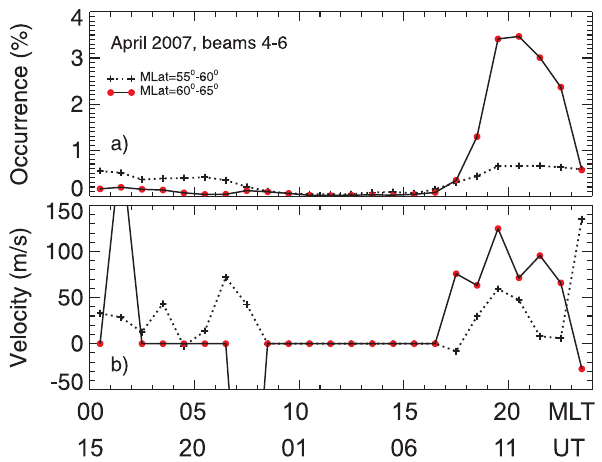
Fig. 2. (a) Hokkaido echo occurrence rate and (b) median velocity versus magnetic local time in two bands of latitudes for observa- tions in April 2007. Only data in beams 4–6 are considered. The Universal Time scale corresponds to the radar